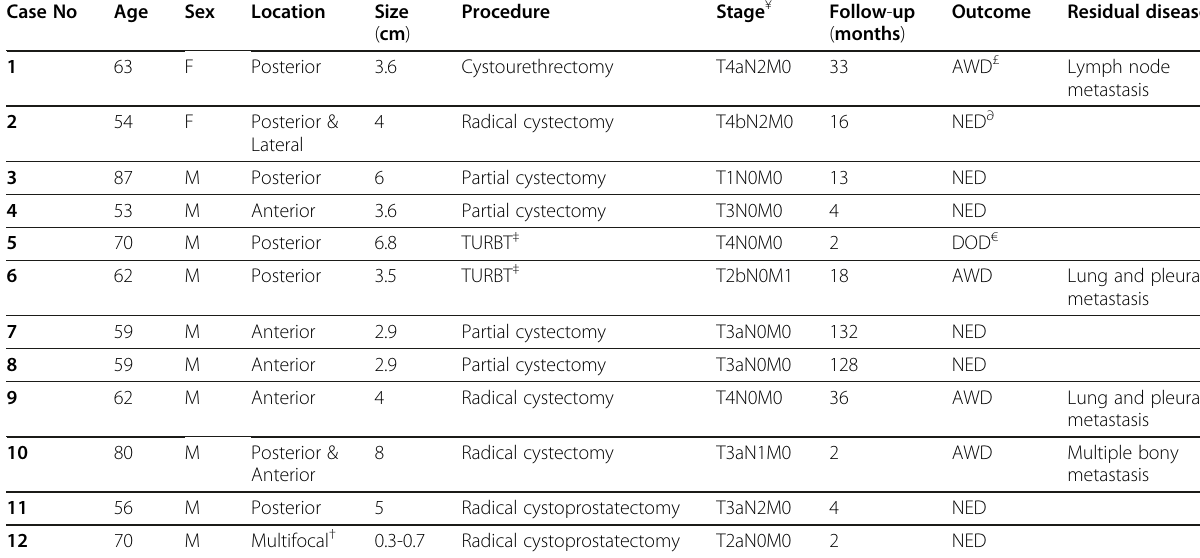
Table 2 Clinical features of primary bladder adenocarcinoma Case No